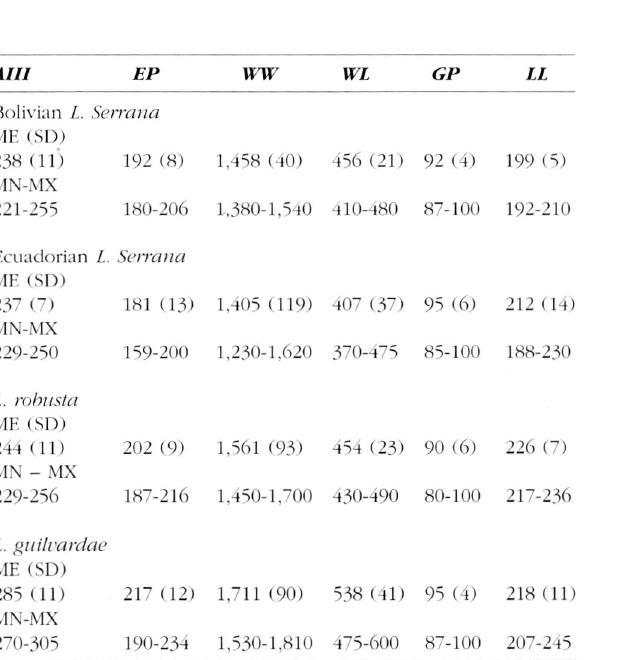
Table I. - Metric properties for some head, wing and genitalia cha racters, all given in microns. ME, mean value ; SD, standard devia tion: MN, minimum; MX, maximum. AIII - third antennal segment. EP - epipharynx, WW - wing width, WL - wing length. GP - genital pump and LL - lateral